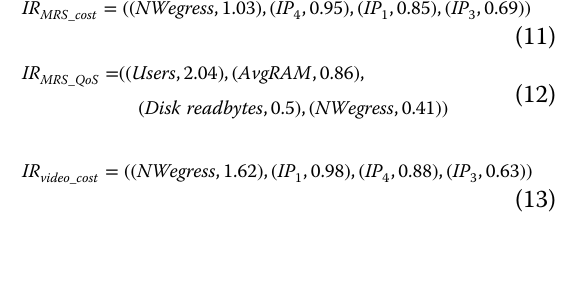
Table 10 Pricing models offered by the infrastructure providers used in the analysis and locations of their data centres Provider Location Pricing